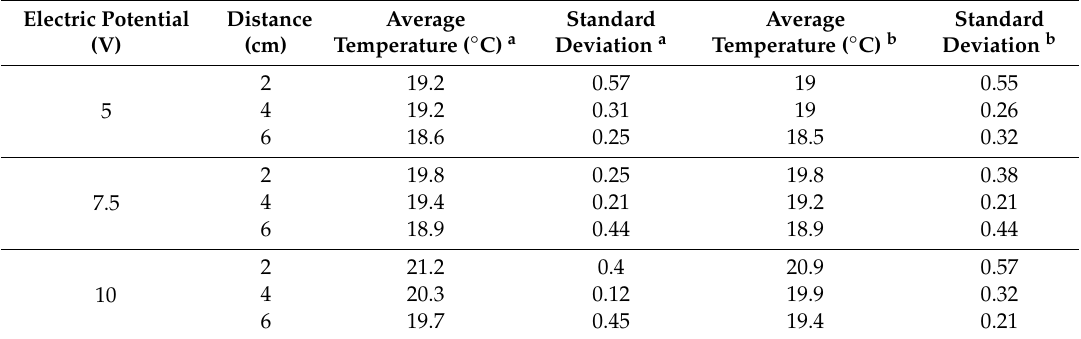
Table 2. Infrared thermography of EM3 with random and aligned fibers recorded at di ff erent electric potentials and